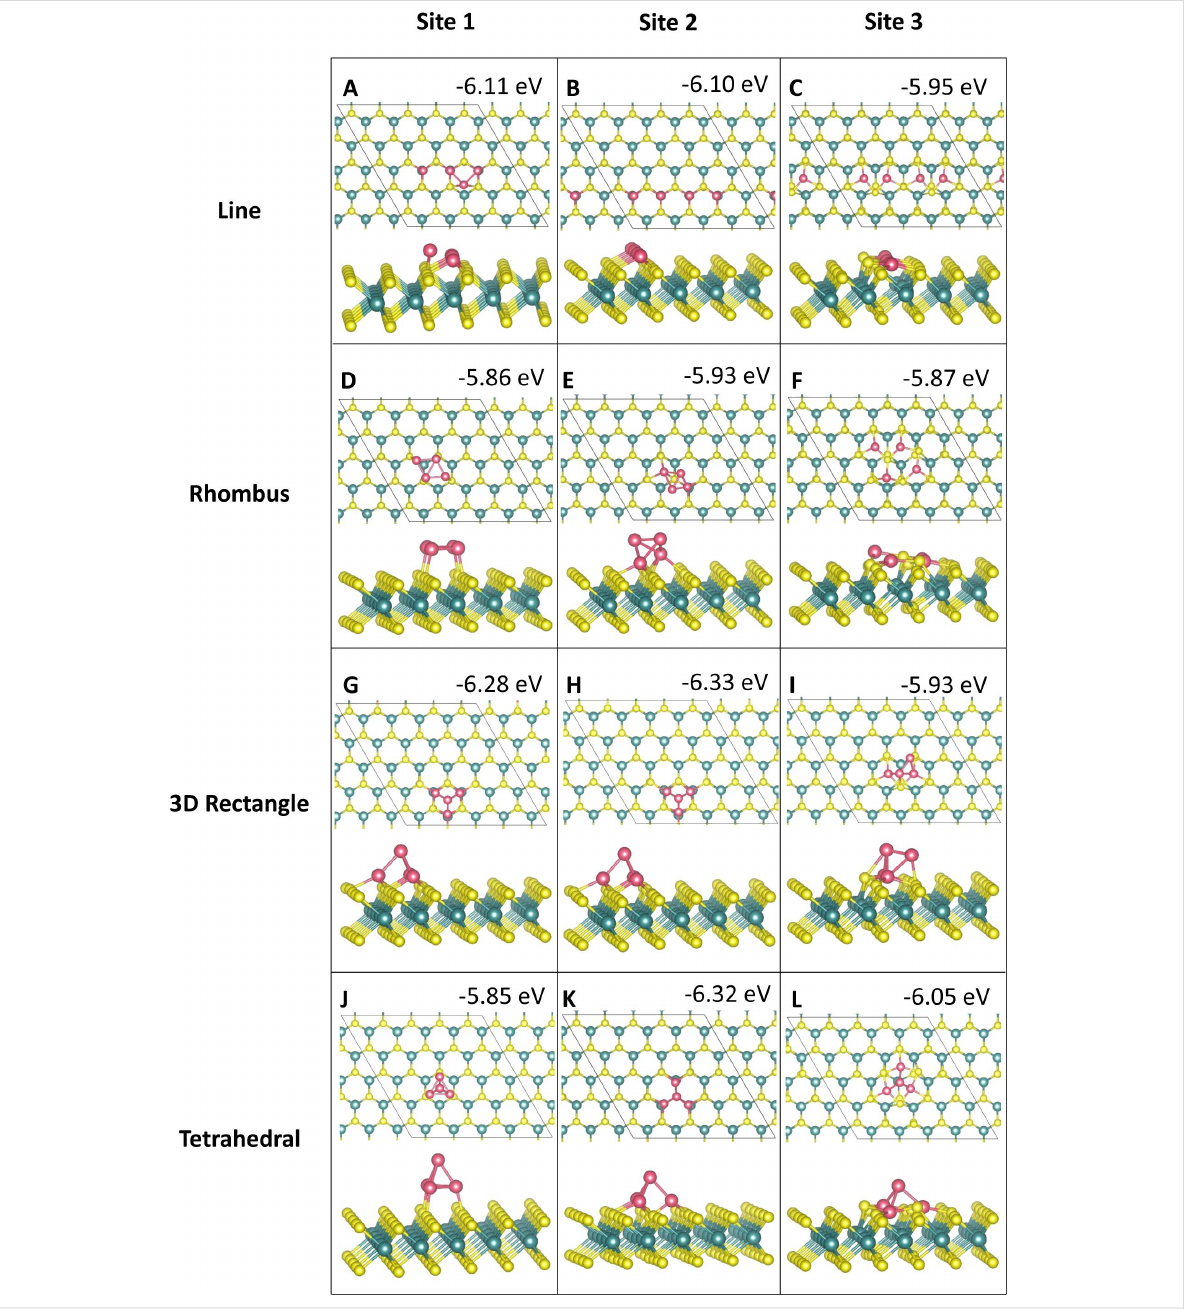
Figure 7: Atomic structure and energies of Co 4 adsorption modes on perfect MoS 2 .